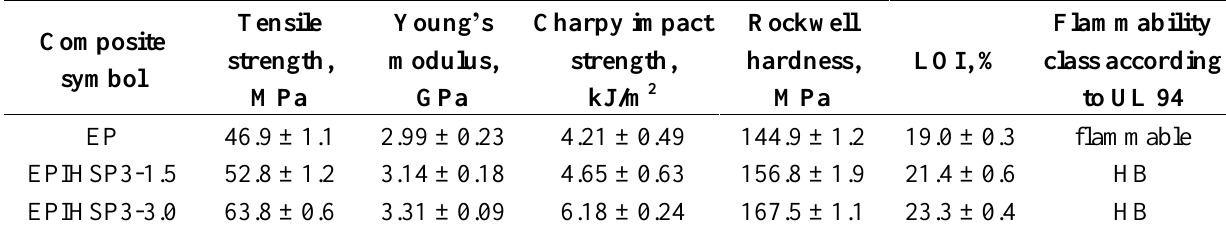
Table 6. Mechanical and flammability properties of tested epoxy composites (±standard